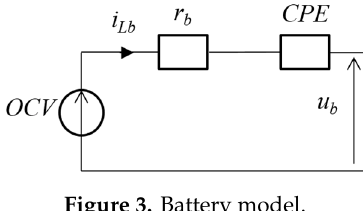
Figure 3. Battery model.